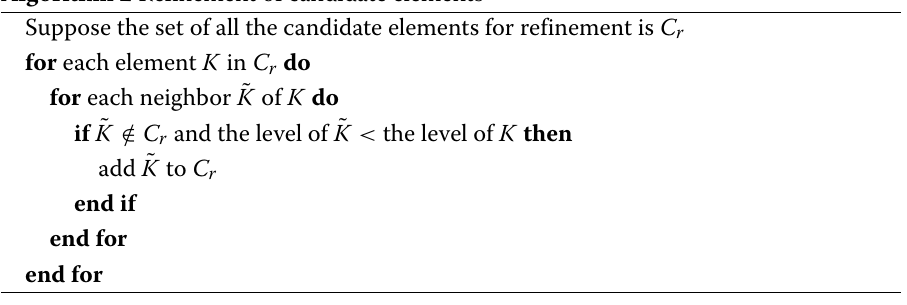
Algorithm 2 Refinement of candidate elements